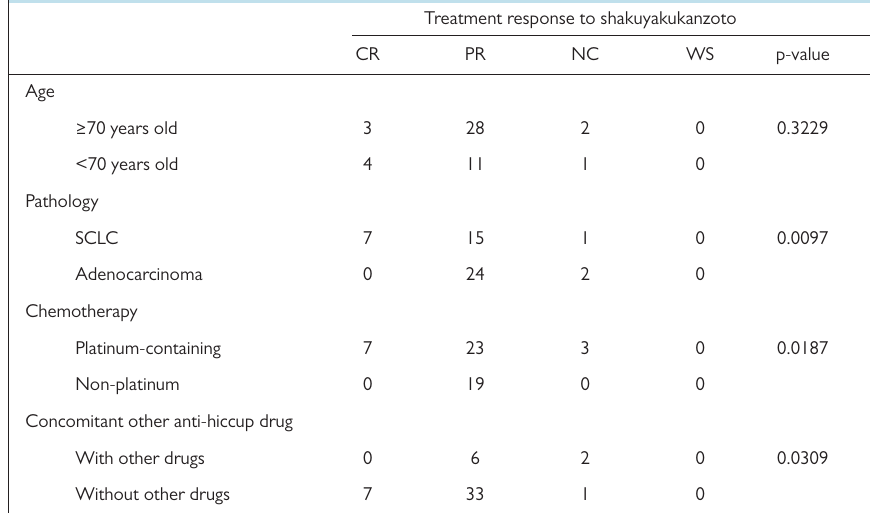
Table 2. Patient characteristics and response to